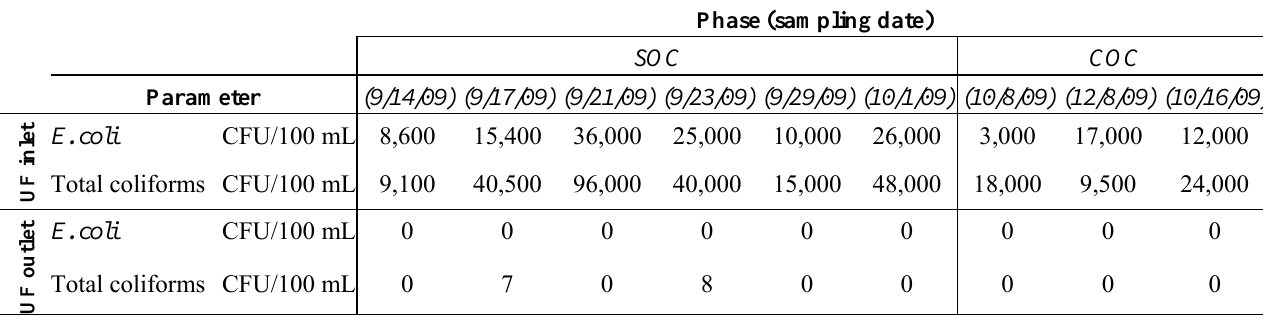
Table 4. E. coli and total coliforms microbial densities measured for the UF inlet and UF outlet samples during the SOC and COC